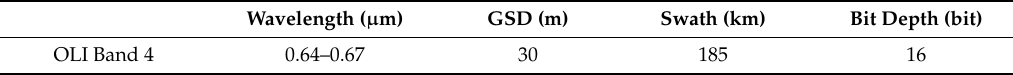
Table 2. Specifications of base map image of OLI (Band 4) onboard Landsat-8.